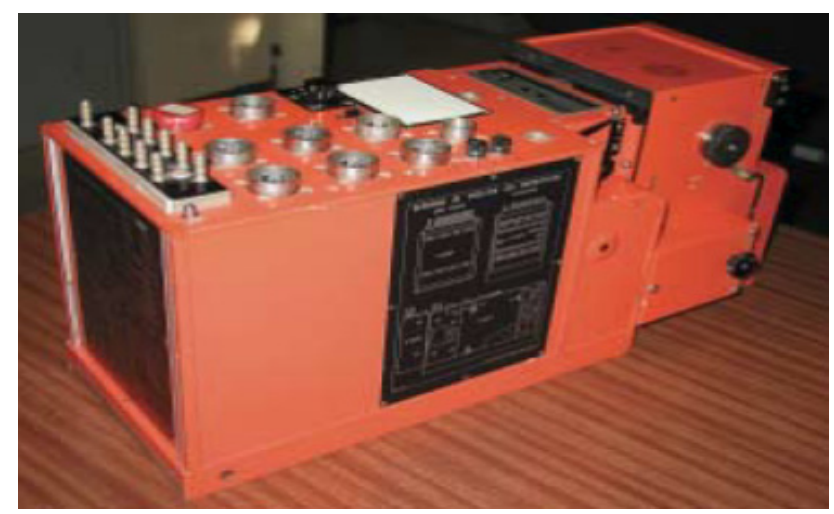
Рисунок 5 – Регистратор A13 (Arhiv Vazduhoplovnog opitnog centra, 2016) Слика 5 – Регистратор А 13 (Arhiv Vazduhoplovnog opitnog centra,